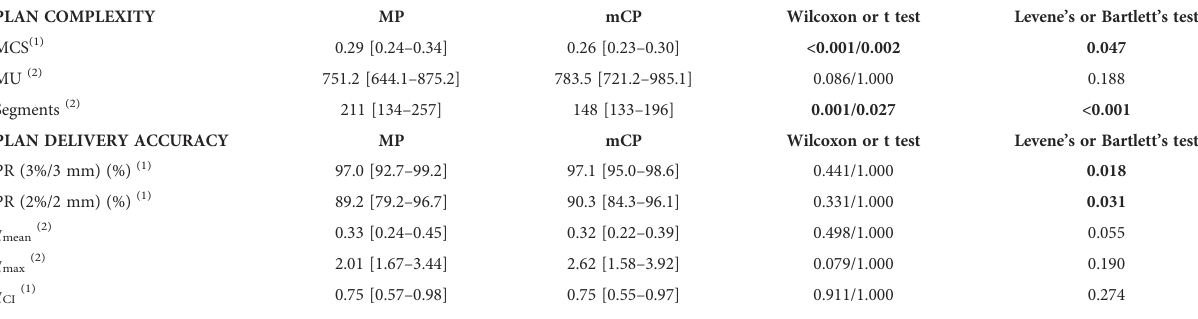
TABLE 3 Comparison of original manual plans and mCycle plans in terms of plan complexity and plan delivery. Median values and ranges are